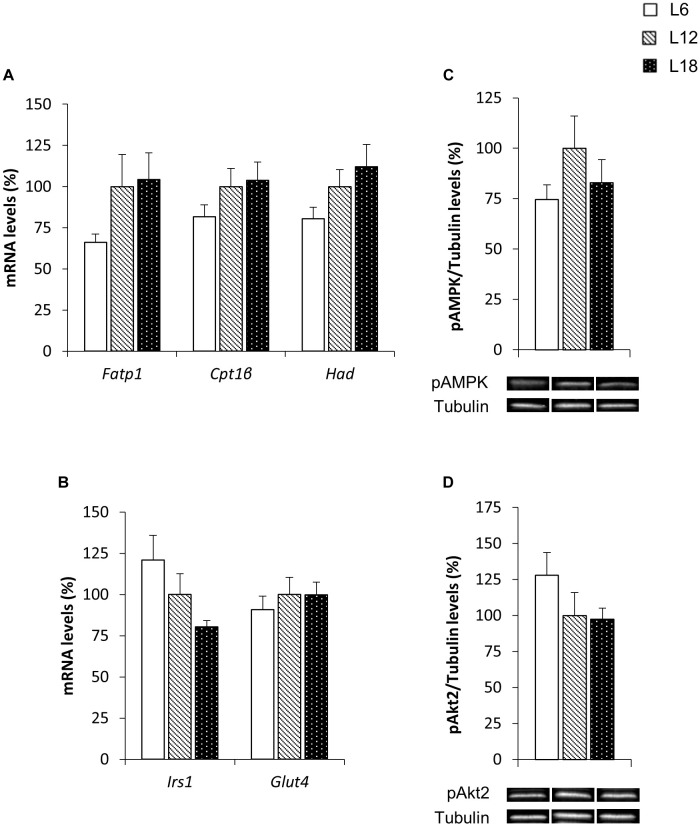
The mRNA expression of genes involved in lipid (A) and glucose (B) metabolism and pAMPK (C) and pAkt2 (D) protein levels in the gastrocnemius muscle of male F344 rats exposed to three different photoperiods for 11 weeks and fed a cafeteria diet for the last 7 weeks. Data are expressed as the mean ± SEM (n = 8). P, photoperiod effect. abMean values with unlike letters were significantly different among groups (one-way ANOVA and Duncan’s post hoc test). The genes and proteins analyzed have already been described in Figure 3.